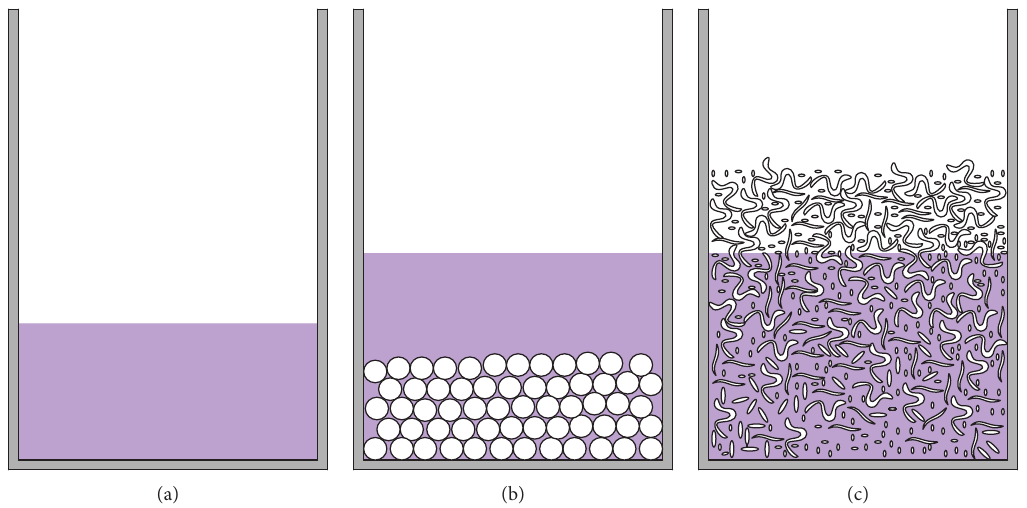
Figure 5: Diagrams of salt and deposits in the crucible during evaporation experiments for the samples comprising (a) salt, (b) salt and steel balls, and (c) salt and steel chips.